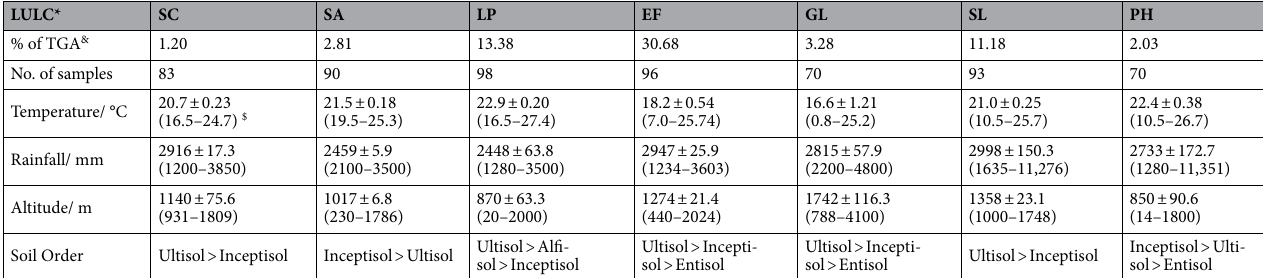
Table 1. Information on percent area, sampling numbers, agro-physical variables and measured soil properties (Mean ± SE) under major land use systems sampled across the study area (NER of India). *LULC: Treatment abbreviations are explained in text; $ : Figures in parenthesis are range of distribution; & TGA = Total geographical area (TGA: 26.22 million ha)